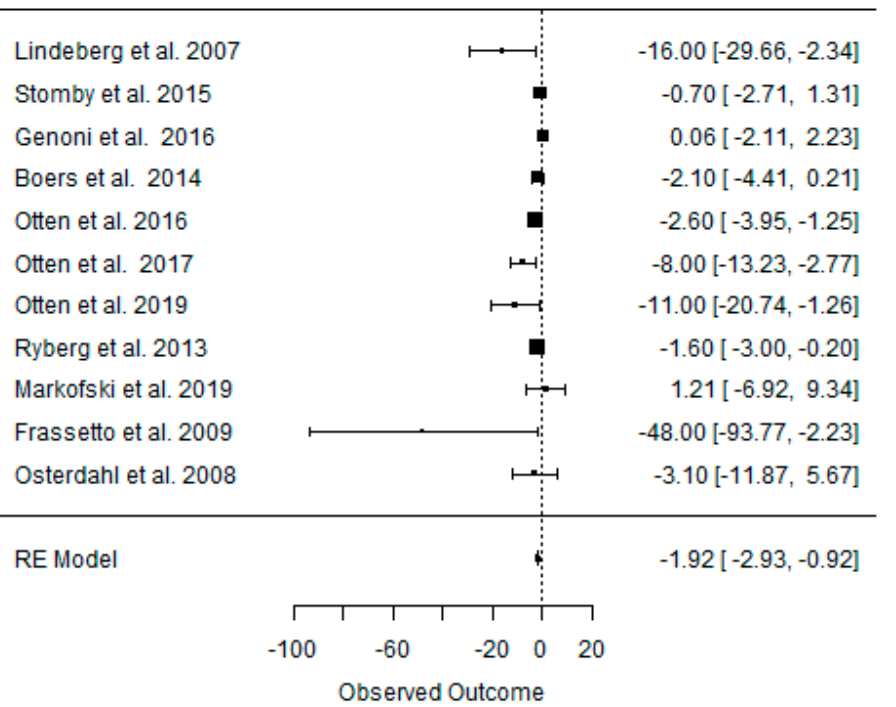
Figure A46. Forest plot of the effect of a CD on fP glucose (mmol/L) in the short term (weighted mean difference).